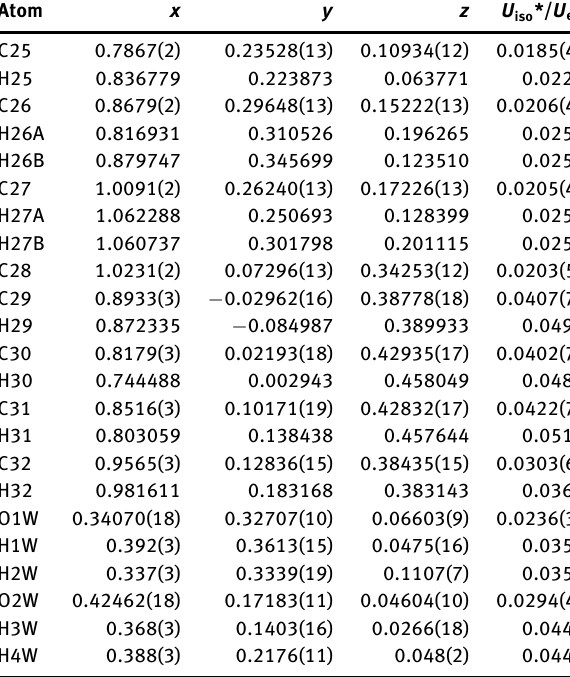
The C-bound atoms were geometrically placed (C—H = 0.95 − 1.00 Å) and refined as riding with U iso (H) = 1.2 U eq (C). The O- and N-bound H-atoms were located in difference Fourier maps but were refined with distance restraints of O—H = 0.84+ − 0.01 Å and